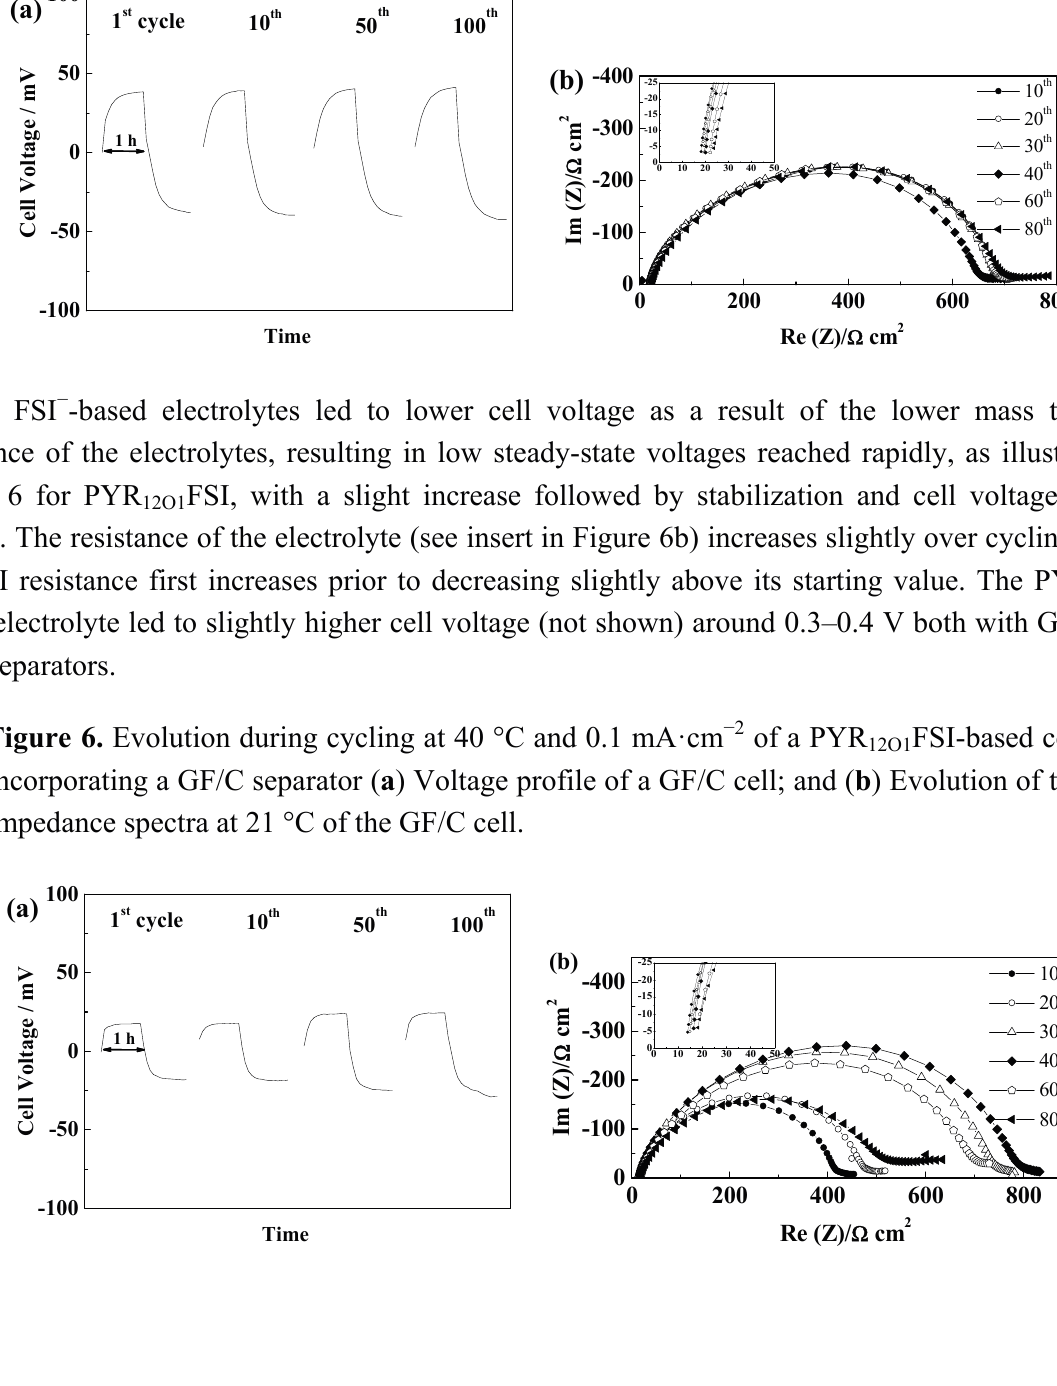
TFSI-based cell 12O1